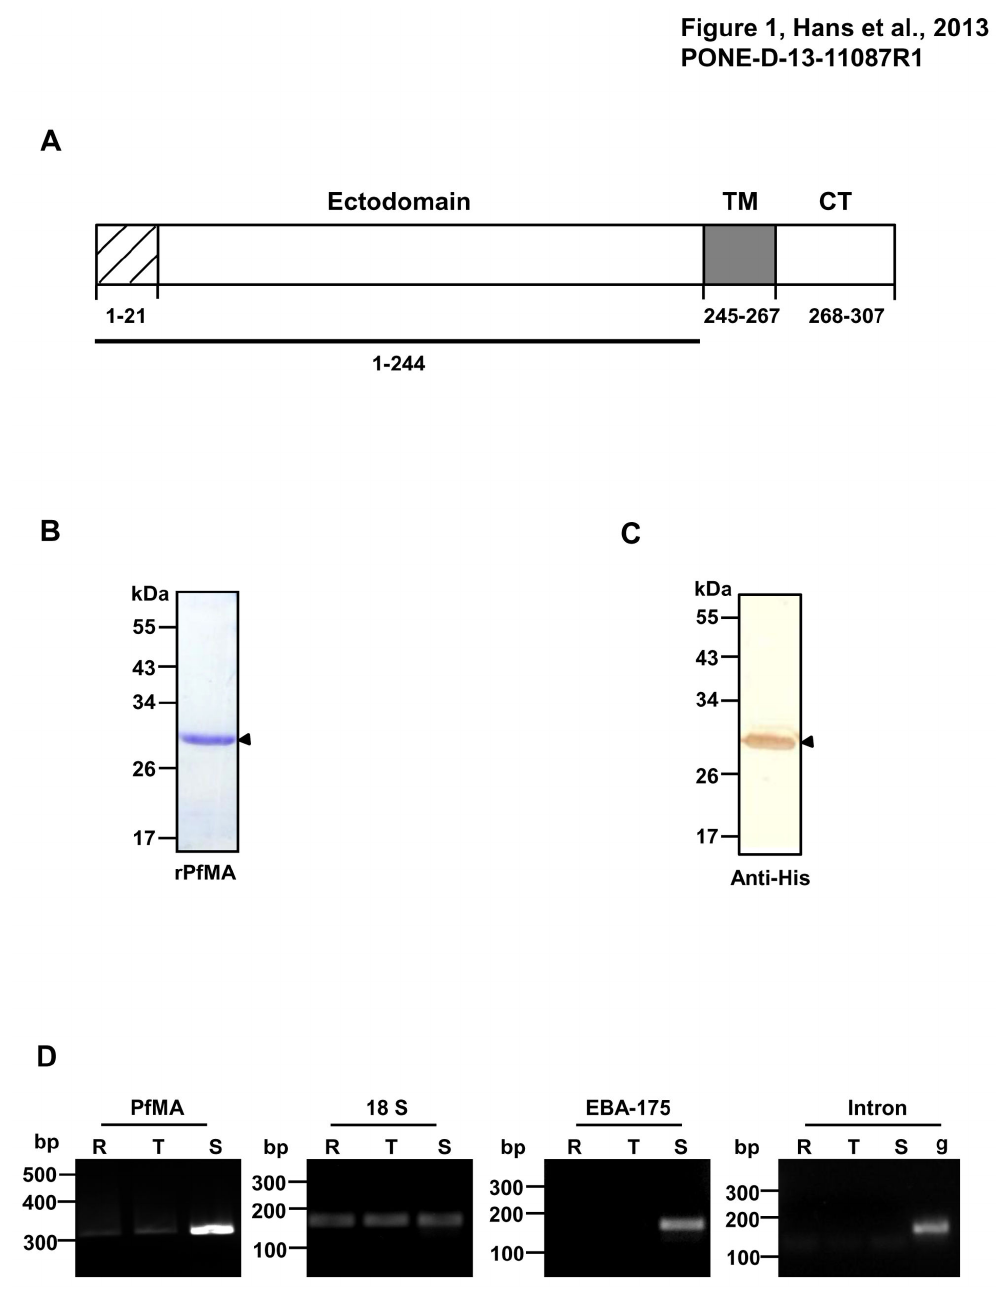
Figure 1. Expression of recombinant PfMA and transcriptional analysis of PfMA in different blood stages of P. falciparum . ( A ) Schematic representation of the primary structure of the 307 amino acid PfMA protein (PlasmoDB ID PF3D7_0316000). PfMA comprises of an N-terminal hydrophobic stretch (residues 1 to 21), a transmembrane TM domain (residues 245-267), and a cytoplasmic tail (CT) at the carboxyl terminal (residues 268-307). The ectodomain (1-244 residues) was expressed in a recombinant form (shown as a bar) and antibodies were raised to this region. ( B ) SDS-PAGE showing purified recombinant PfMA (rPfMA) at the expected size of 30kDa (shown with arrow). ( C ) Detection of rPfMA by anti-polyHistidine tag antibody (Sigma) by immunoblotting (shown with arrow) ( D ) RT-PCR analysis of PfMA in different blood stages of P. falciparum cDNA prepared from different blood stages i.e. ring (R), trophozoite (T) and schizont (S) were used to amplify PfMA transcripts using gene specific primers. The level of PfMA transcription increased from the ring to schizont stages. As a control for equal amounts of RNA from the three stages, RT-PCR was performed with the 18S rRNA primers. RT-PCR of EBA-175 was analyzed as a control for stage specificity. Intronic primers showed amplification only in genomic DNA (g) and not in cDNA from all the stages. doi: 10.1371/journal.pone.0074790.g001 PLOS ONE |